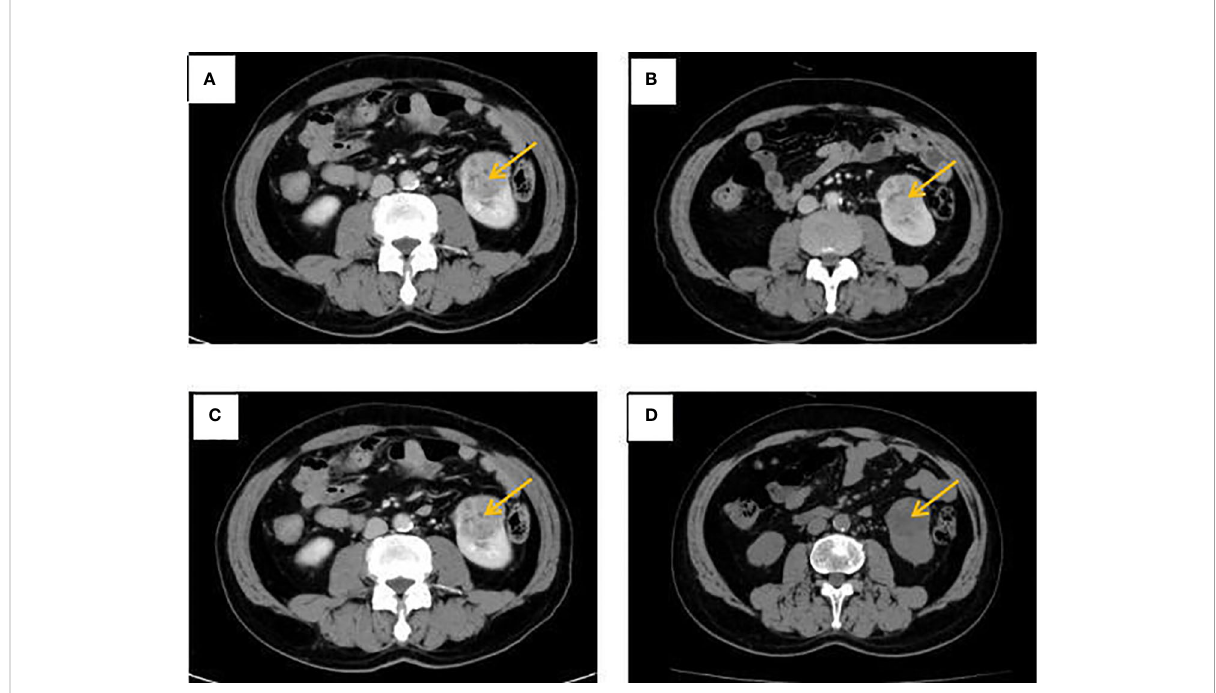
FIGURE 2 Abdominal CT at different times. (A) The left kidney lesion before treatment. (B) CT revealed a stable disease after 2 cycles of albumin-bound paclitaxel and cisplatin in combination with sintilimab. (C) CT revealed a stable disease after 6 cycles of albumin-bound paclitaxel and cisplatin in combination with sintilimab. (D) No signi fi cant change in left kidney lesion after sequential 2 cycles of sintilimab immune monotherapy maintenance